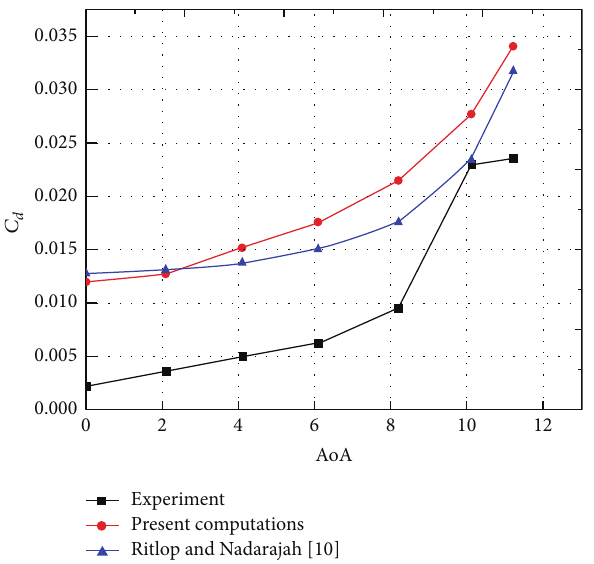
Figure 5: Variation of drag coefficient with angle of attack.